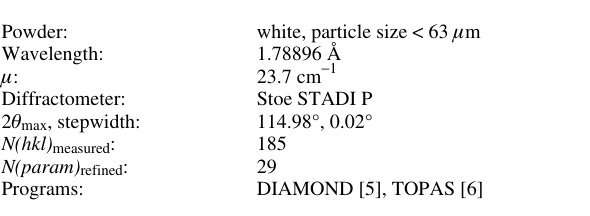
Table 1. Data collection and handling.